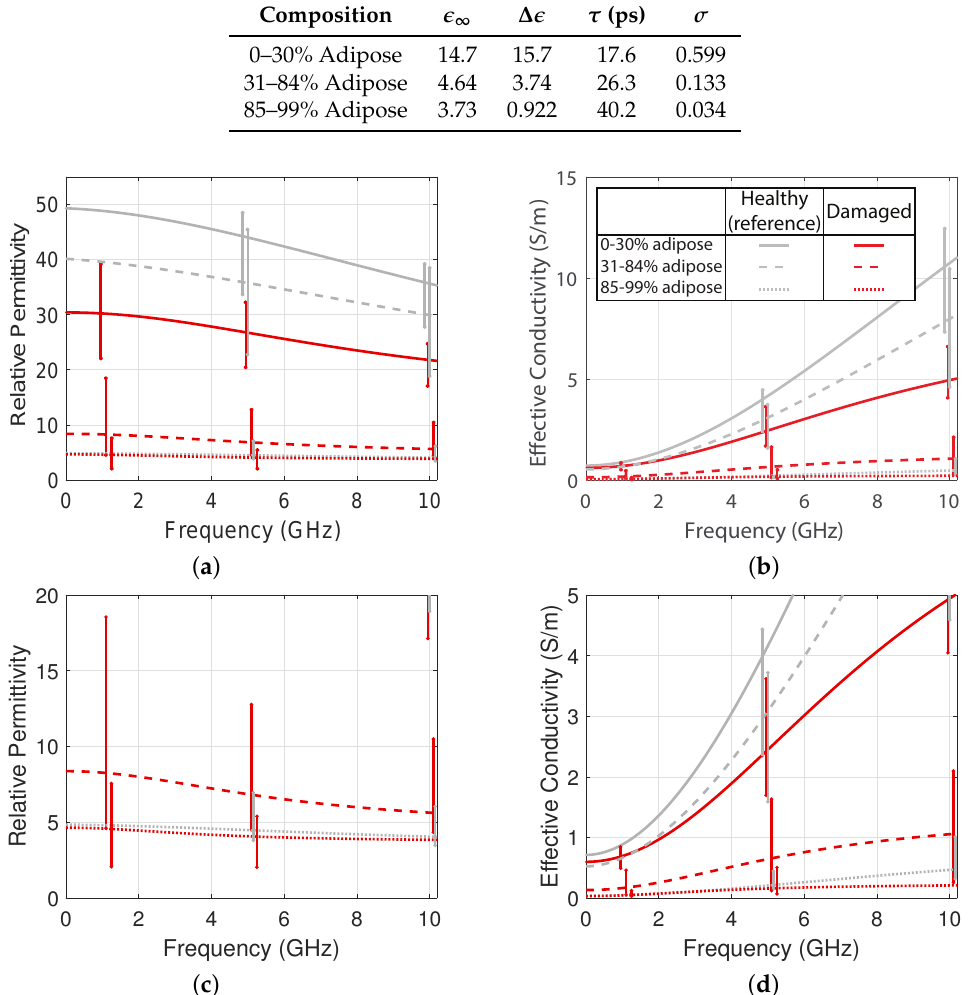
Figure 13. Median fitted curves for the permittivity ( a and c ) and conductivity ( b and d ) of ablated breast tissue (red lines, this study) as compared to healthy breast tissue (gray lines, [15]). The variability bars show the 25th and 75th percentiles. Bottom plots ( c and d ) provide more detail in the lower range of the